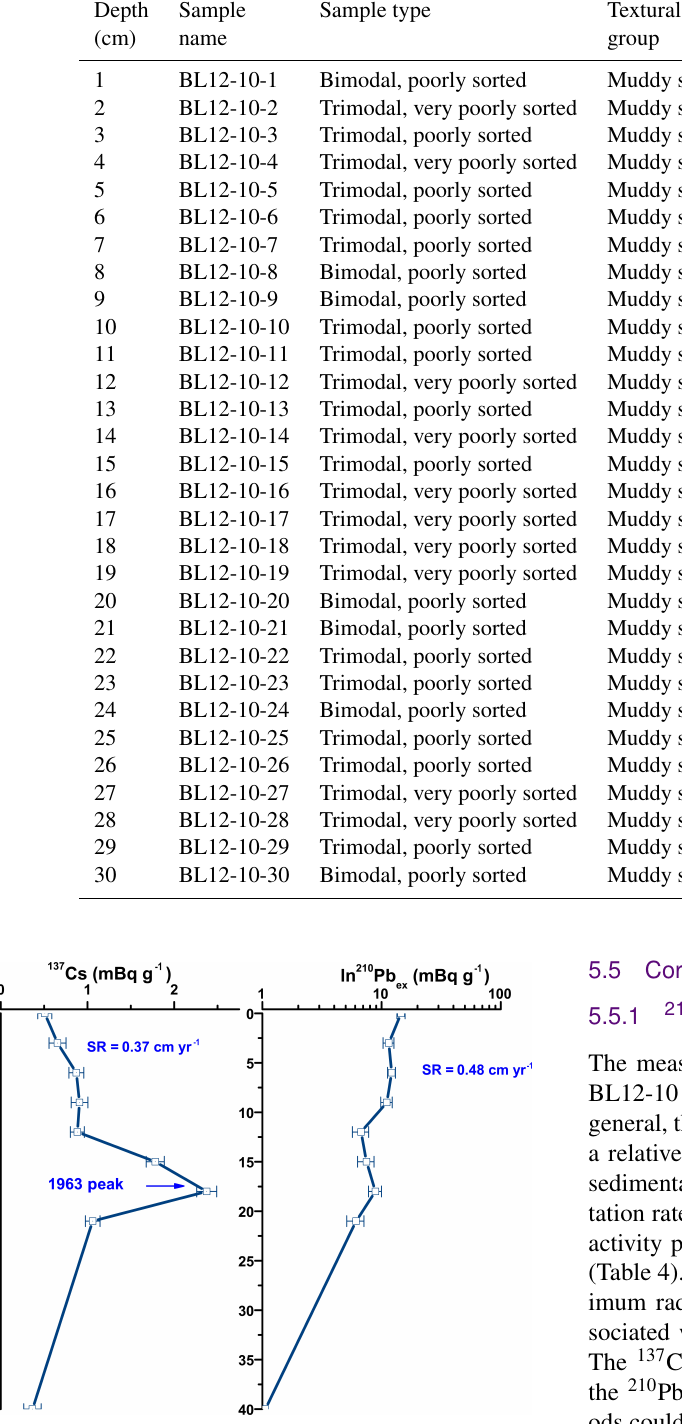
Figure 10. 210 Pb ex and 137 Cs activity–depth profiles along core BL12-10. SR: sedimentation rate (cmyr − 1